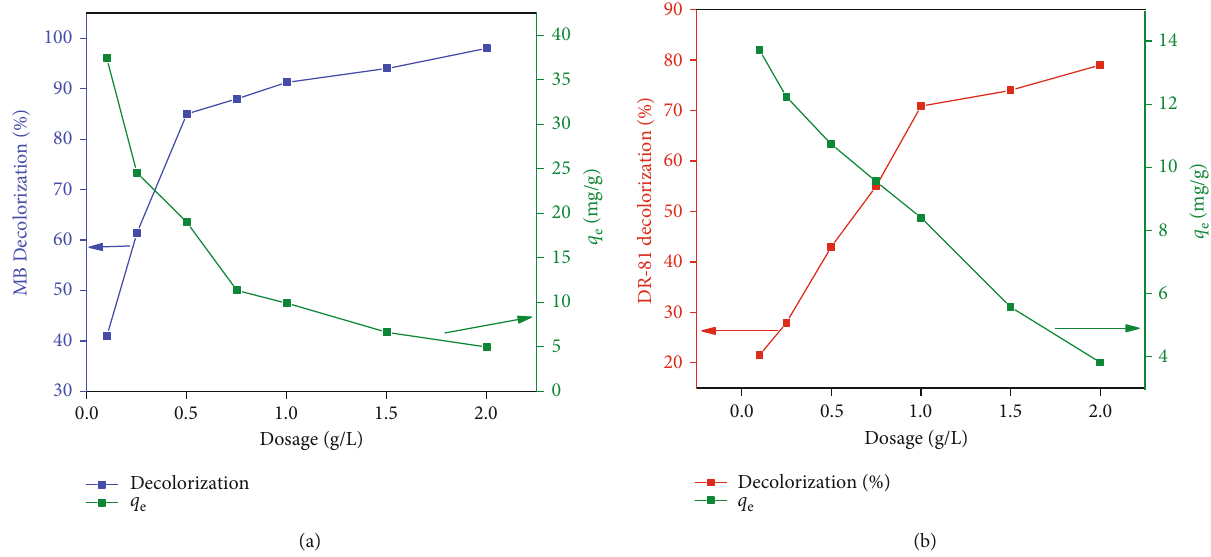
Figure 10: In fl uence of the dosage of the synthesized Zn-adeninate bio-MOF on the decolorization of (a) MB and (b) DR-81 (contact time = 10 min for MB and 30min for DR-81, pH = 7 , initial dye concentration = 10 ppm, stirring speed = 300 rpm, and solution temperature = 23 ° C).